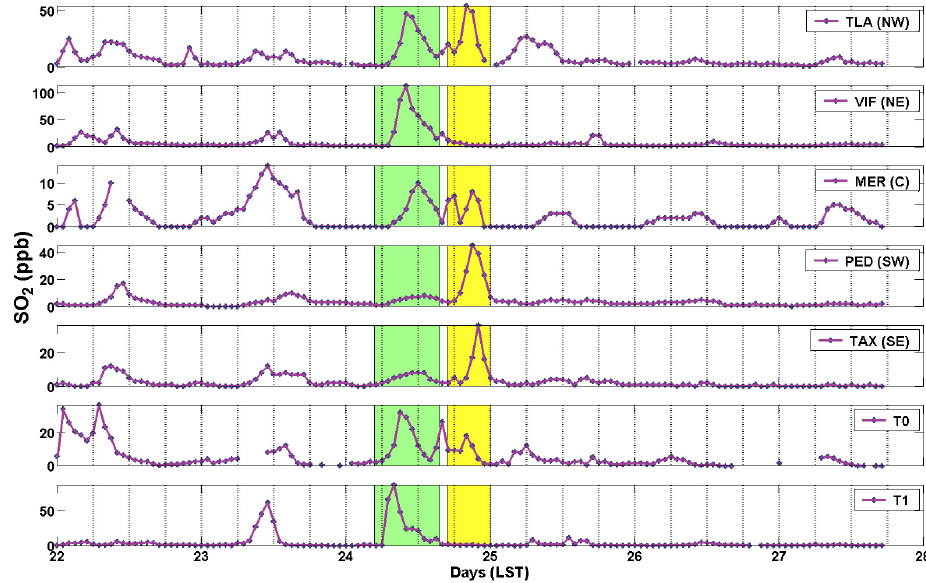
Figure 2. SO 2 time series of RAMA monitoring stations and MILAGRO supersites. Each station is representative for the respective region within the MCMA. The plot shows the peak on 24 March (green), and on 25 March (yellow). Dotted lines are plotted every 6h.